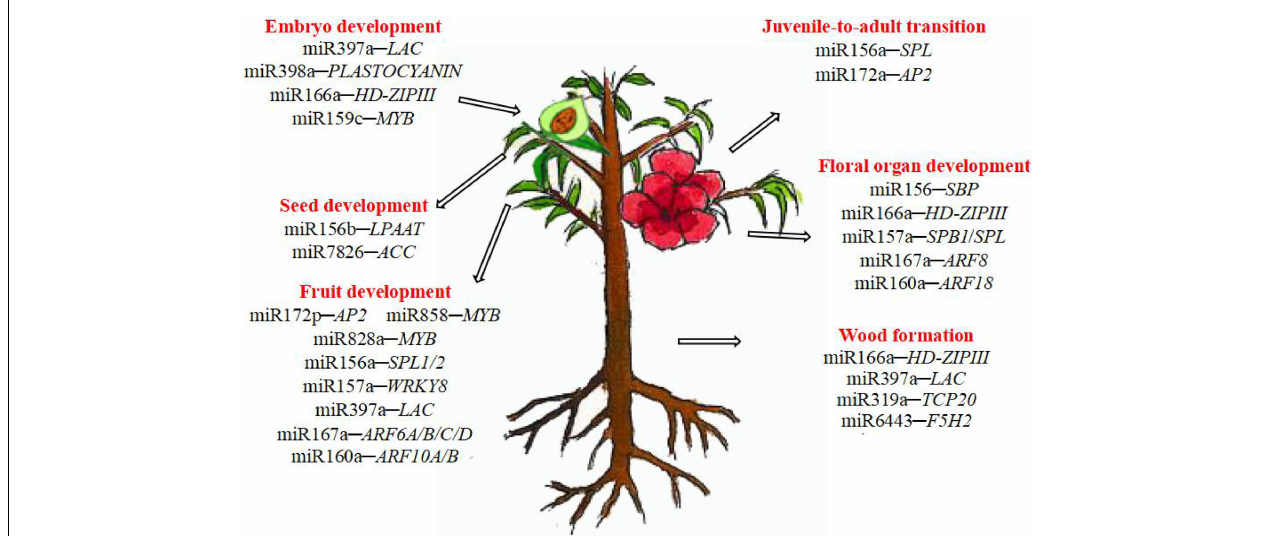
FIGURE 1 | The role of miRNA in the growth and development of woody